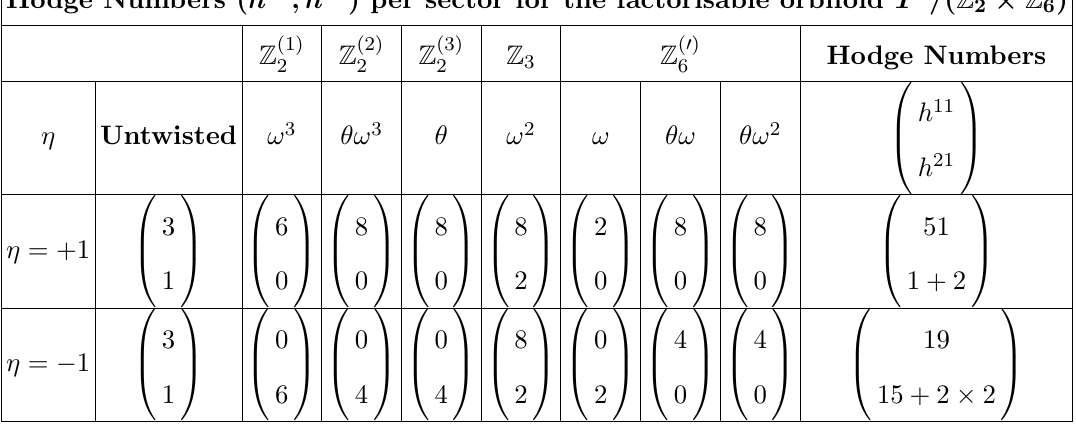
Table 1 . Hodge numbers ( h 11 ; h 21 ) per sector for the factorisable toroidal orbifold T 6 = ( Z 2 (cid:2) Z 6 ) with lattice con(cid:12)guration SU(2) 2 (cid:2) SU(3) (cid:2) SU(3). In the absence of discrete torsion, the Hodge numbers match those of the orbifold T 6 = ( Z 2 (cid:2) Z 2 ), namely ( h 11 ; h 21 ) = (51 ; 3), but with a di(cid:11)erent distribution over twisted sectors. Considering the orbifolds with discrete torsion leads to a reduction of the initial 51 three-cycles on T 6 = ( Z 2 (cid:2) Z 2 ) to only 19 three-cycles on T 6 = ( Z 2 (cid:2) Z 6 ) due to the additional Z 3